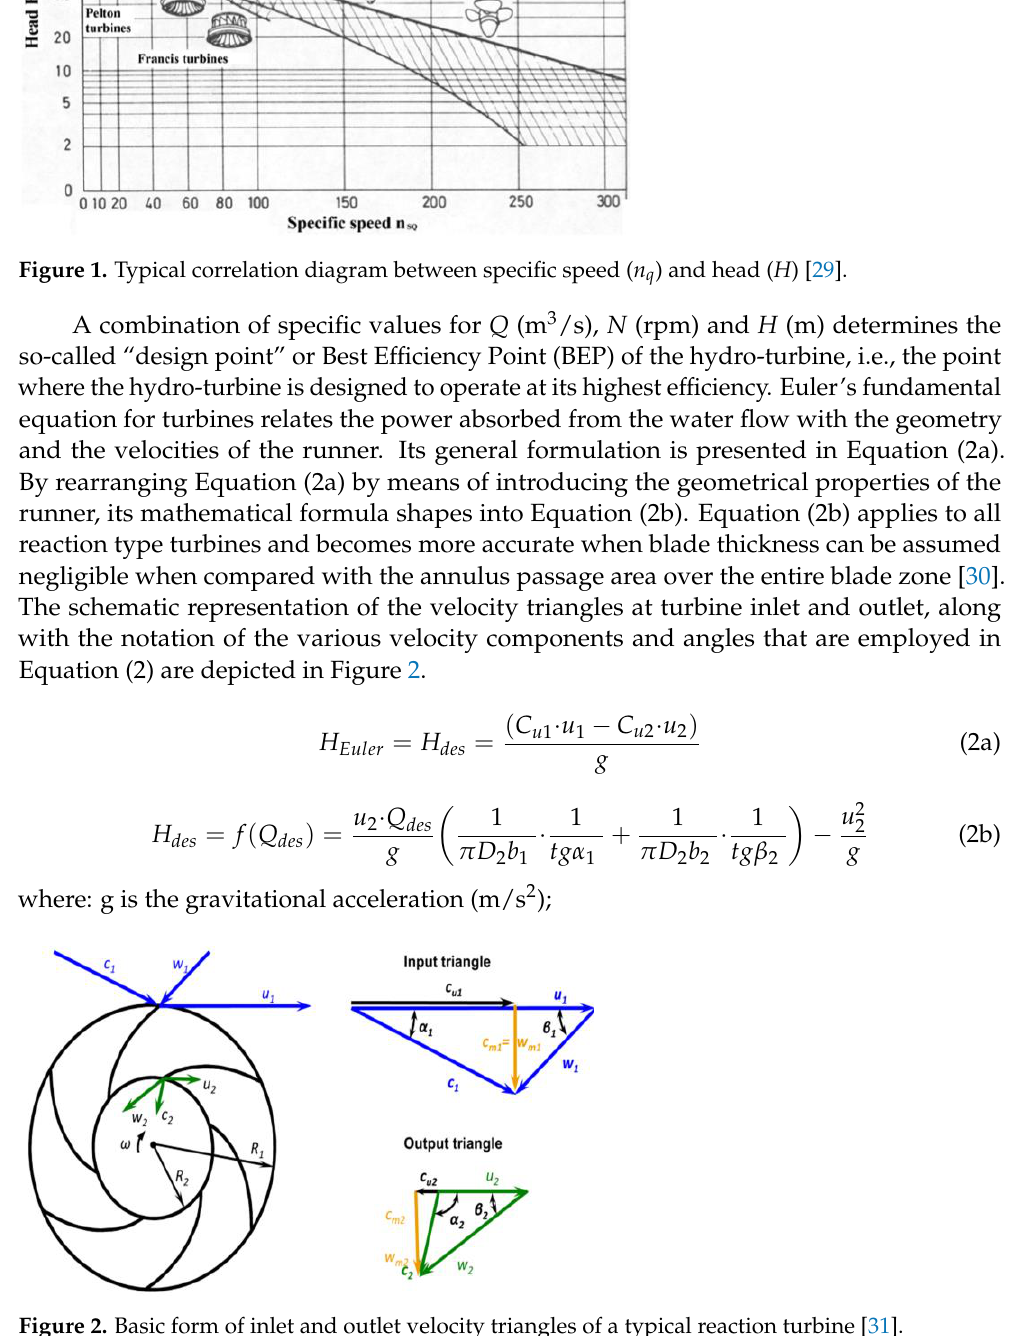
imposing a specific head drop regardless of the efficiency, as is required by the operation of PRVs, it is necessary to estimate all corresponding working points. This is possible by constructing both the η– Q (efficiency-flow rate) curve and the characteristic H – Q (head- flow rate) curve, which indicate the way that efficiency and head change with varying flow rate, respectively. Normally, the H – Q curve is a strictly increasing function, as it is showcased in Figure 3 [32] and becomes evident from Equation (2.b) by calculating H as a function of Q . Such curves can be drawn for a specific rotational speed value and abso- lute flow angle at inlet, which in turn depends on guide vane opening. From the ideal Euler line it can be observed that for each such curve there is always a critical flow rate ( Q o ) below which the hydro-turbine does not work as intended, but enters a mode of op- eration where it behaves neither as turbine nor as pump [33]. By changing the absolute flow angle at inlet to a bounded range and for ming the equivalent η– Q and H – Q curves, the behavior of the same machine for different operating points (flow rates, heads and rotational speeds) can be assessed. Equation (3) suggests that the final characteristic H – Q curve, also known as the actual performance curve, results from the ideal Euler line if all forms of losses (i.e., hydraulic, volumetric, kinetic) are included. In practice, hydraulic losses (i.e., friction and shock losses) are the most consequential, and hence it is essential to introduce their mathematical expressions by Equations (4) and (5). Then, the hydraulic efficiency which accounts for these losses is calculated in Equation (6). 𝐻 𝑎𝑐𝑡𝑢𝑎𝑙 = 𝐻 𝑖𝑑𝑒𝑎𝑙 + 𝐻 𝑙𝑜𝑠𝑠𝑒𝑠